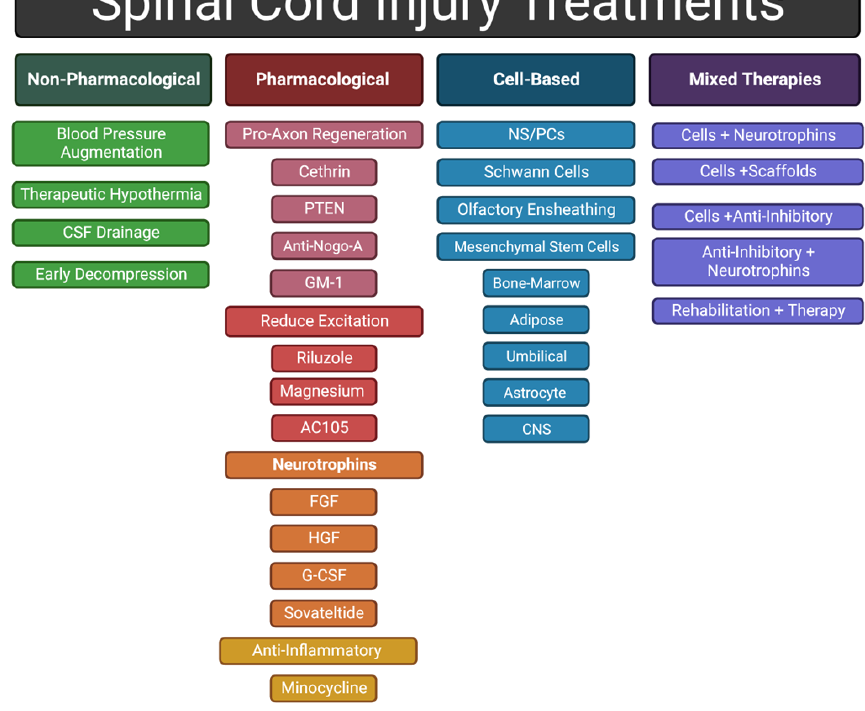
Figure 3. General categories of approaches to treating an SCI discussed in this review.